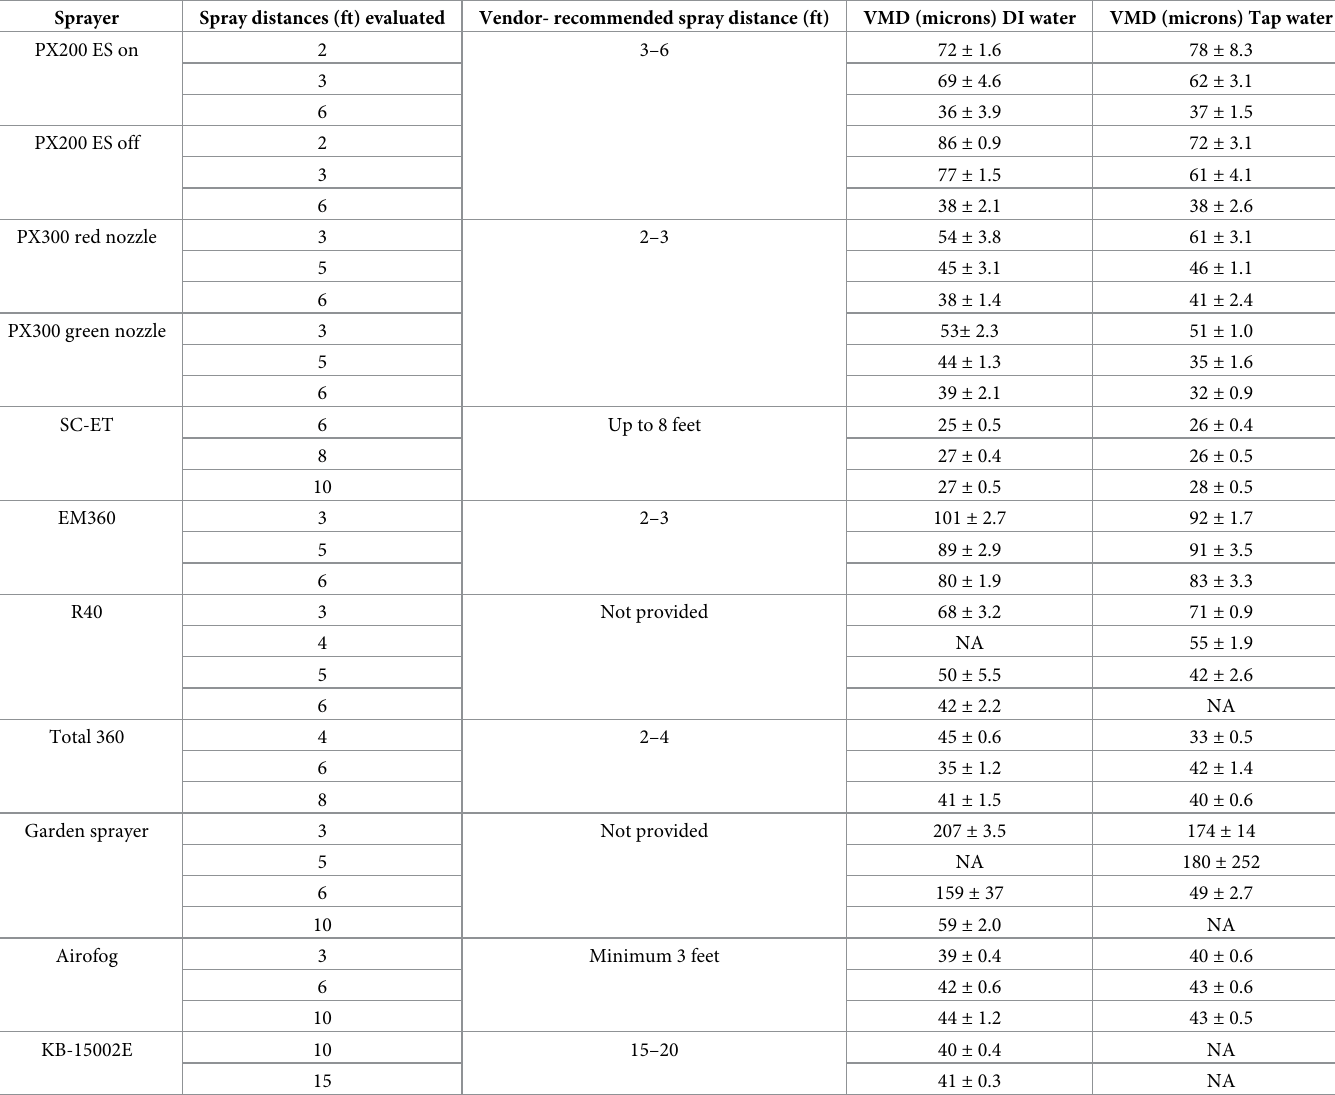
Table 3. Average volume median diameter for spray devices tested with deionized and tap